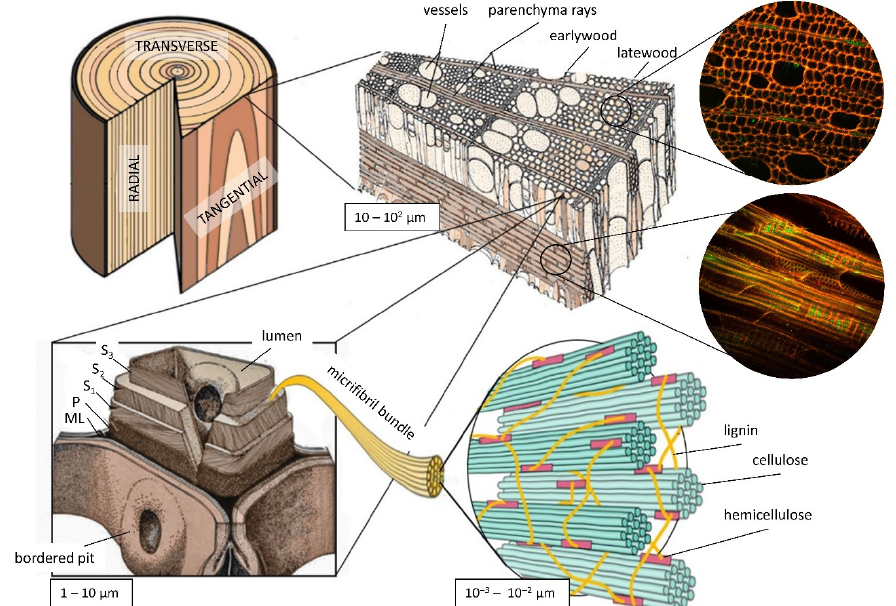
Figure 1. Wood sections at the macroscale ( top left ); schematic microstructure of hardwood species ( top middle ) with NLO images (diameter = 200 µ m) of the microstructure of poplar xylem in transverse and radial sections ( top right ). Schematic representation of cell wall layers—ML, middle lamella; P, primary cell wall; S1, S2, and S3, sublayers of secondary cell wall ( bottom left ); close up of a microfibril bundle from S2 showing individual crystallites of cellulose glued together by the interfibrillar compounds of hemicellulose and lignin ( bottom right